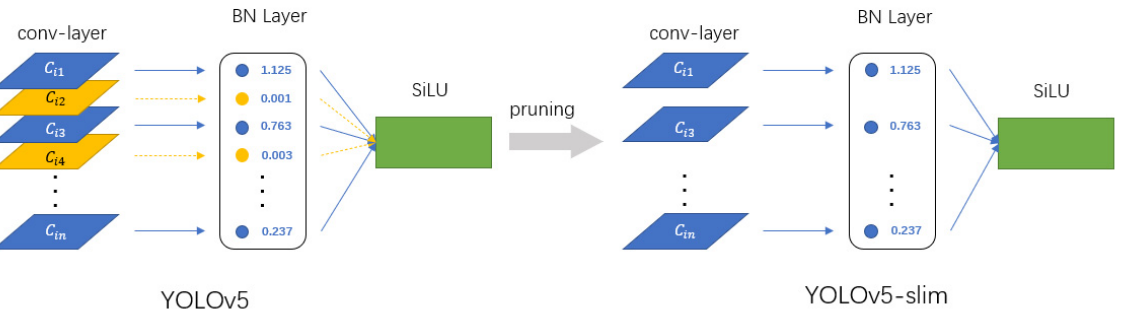
Figure 6. Pruning of YOLOv5 models.